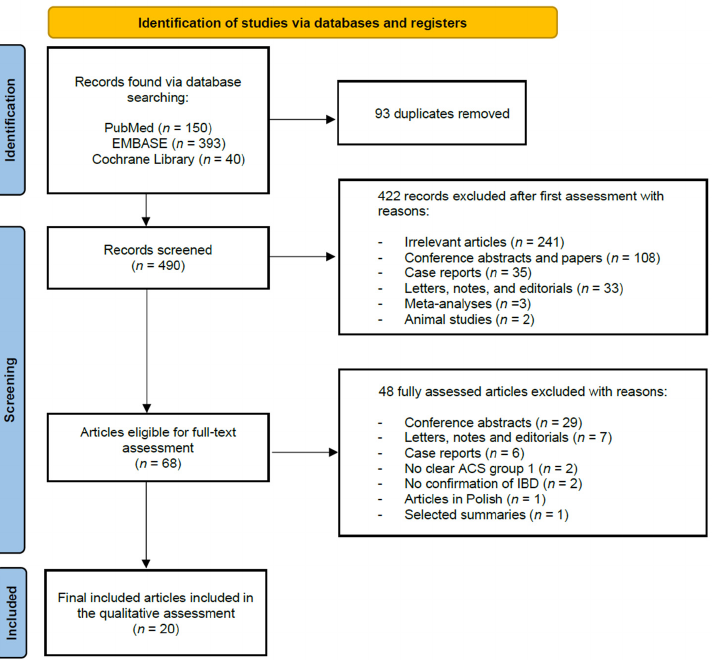
Figure 1. PRISMA flow diagram describing the identification, screening, and inclusion phases of our systematic review.